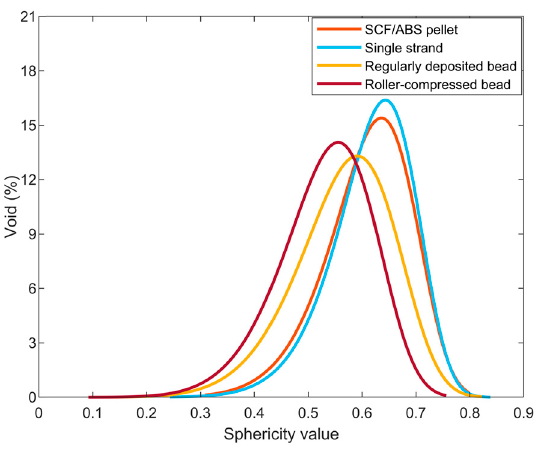
Figure 11. Weibull distribution of void sphericity in four different scanned parts.